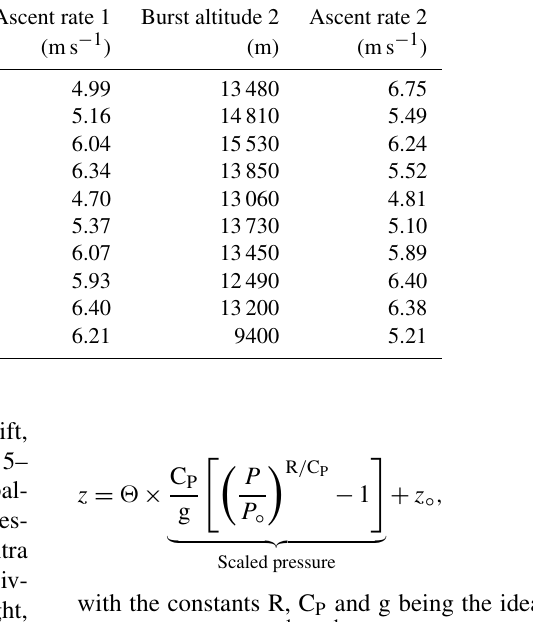
Table 1. Flight data from all flights conducted during the summers of 2014 and 2015. Each date had two separate flights to produce one estimate of